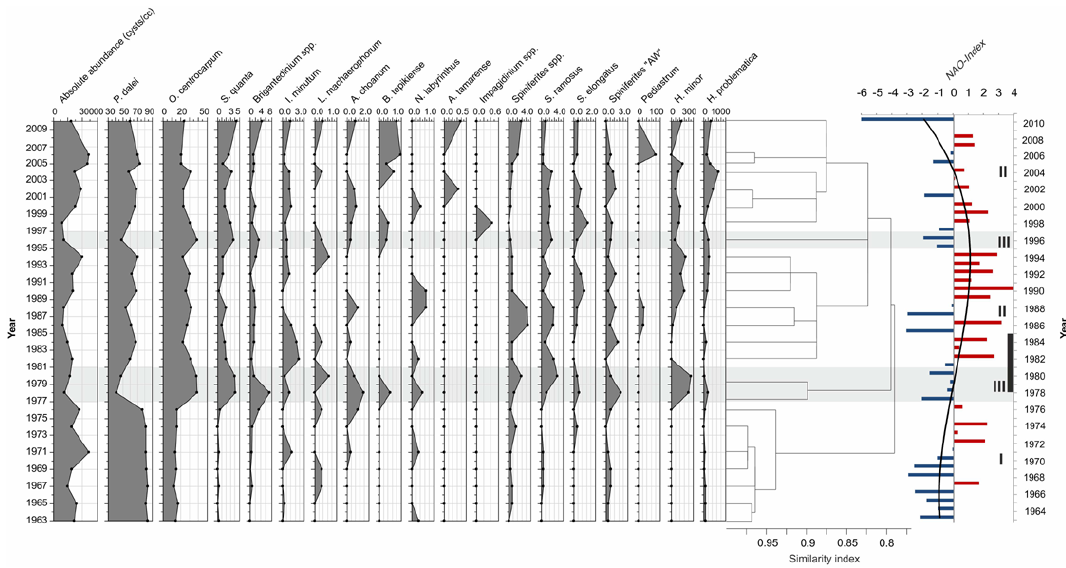
Fig. 6. Cyst assemblages in MC 99-1 and associated groups according to cluster analysis; cyst concentrations and Chlorophycean and Prasinophyceae algae are given in nbcc − 1 , relative dinocyst abundances are given in %; the NAO index is shown to the right (Hurrell, 1995). Black bar on the right axis marks the period (1978–1985) of major hydropower development/implementation in the Orkla river (L’Abée-Lund et al.,